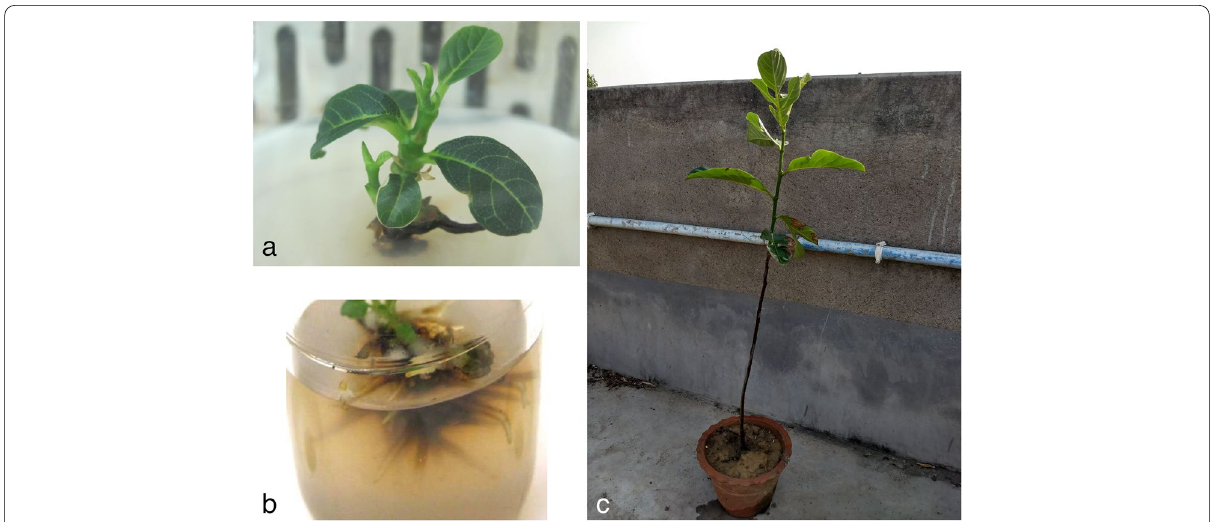
Fig. 2 Micropropagation of Artocarpus heterophyllus L. a Enlargement and induction of new shoot and leaf after the second subculture period in Murashige and Skoog (MS) medium supplemented with 1.5 mg L -1 6-benzylaminopurine (BAP), Indole-3-butyric acid (IBA) at 0.5 mg L -1 , and NAA at 0.1 mg L -1 in combination. b Well development of roots in quarter strength of MS medium supplemented with 0.5 mg L -1 IBA and 0.1 mg L -1 BAP in combination. c Six-month-old secondary hardened plants in earthen